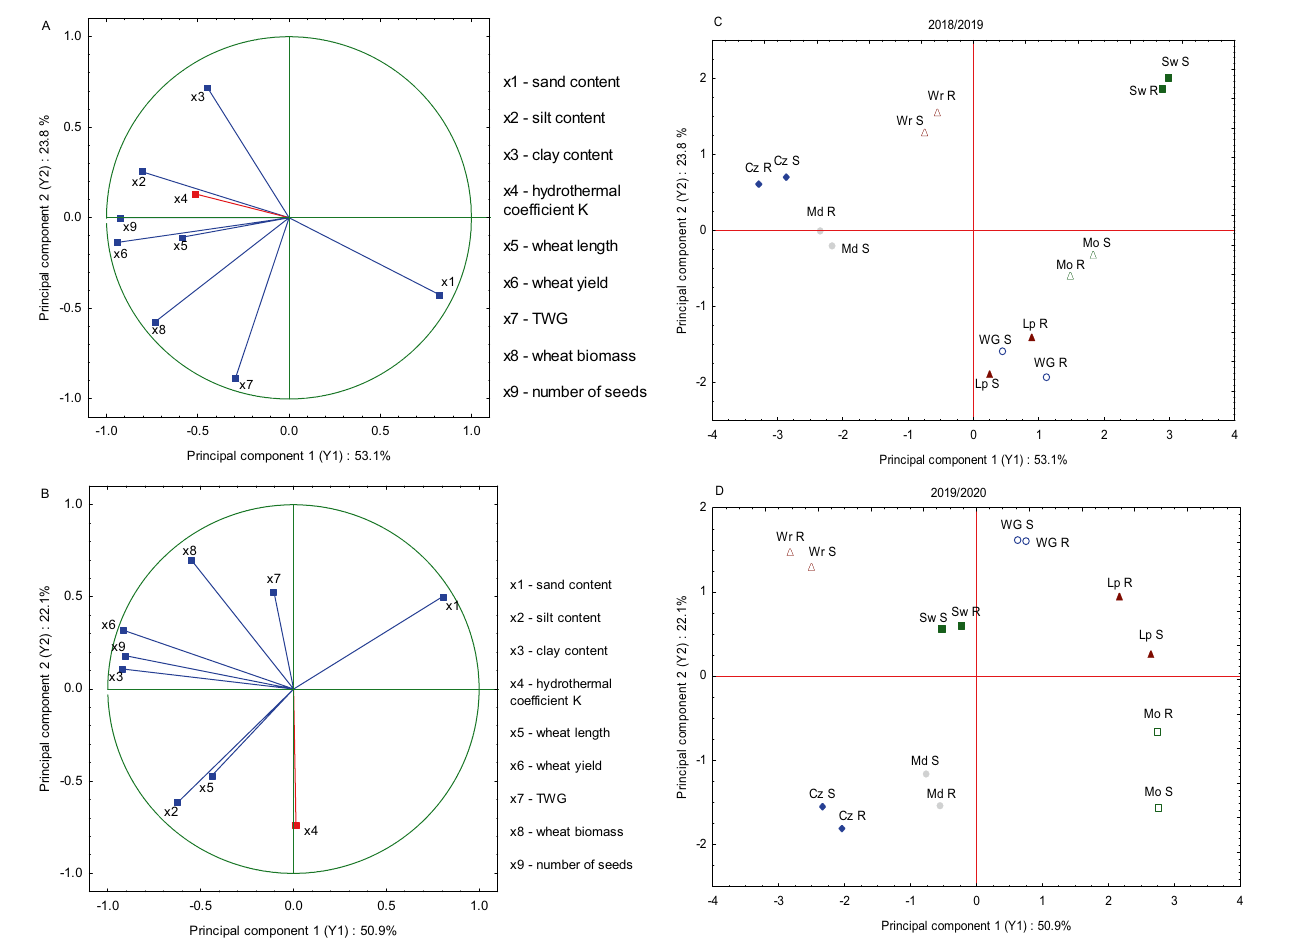
Figure 7. Projection of environmental characteristics and winter wheat characteristics growing in the mixtures with blackgrass resistant (R) and susceptible (S) biotypes in the seasons 2018/19 ( A , C ) and 2019/20 ( B , D ) on two principal components. Sites of experiments: Lp Lipnik, Mo Mochełek, Md Mydlniki, Cz Czesławice, Sw Swojczyce, WG Winna Góra, Wr Wrocław. TGW thousand grain weight, K hydrothermal